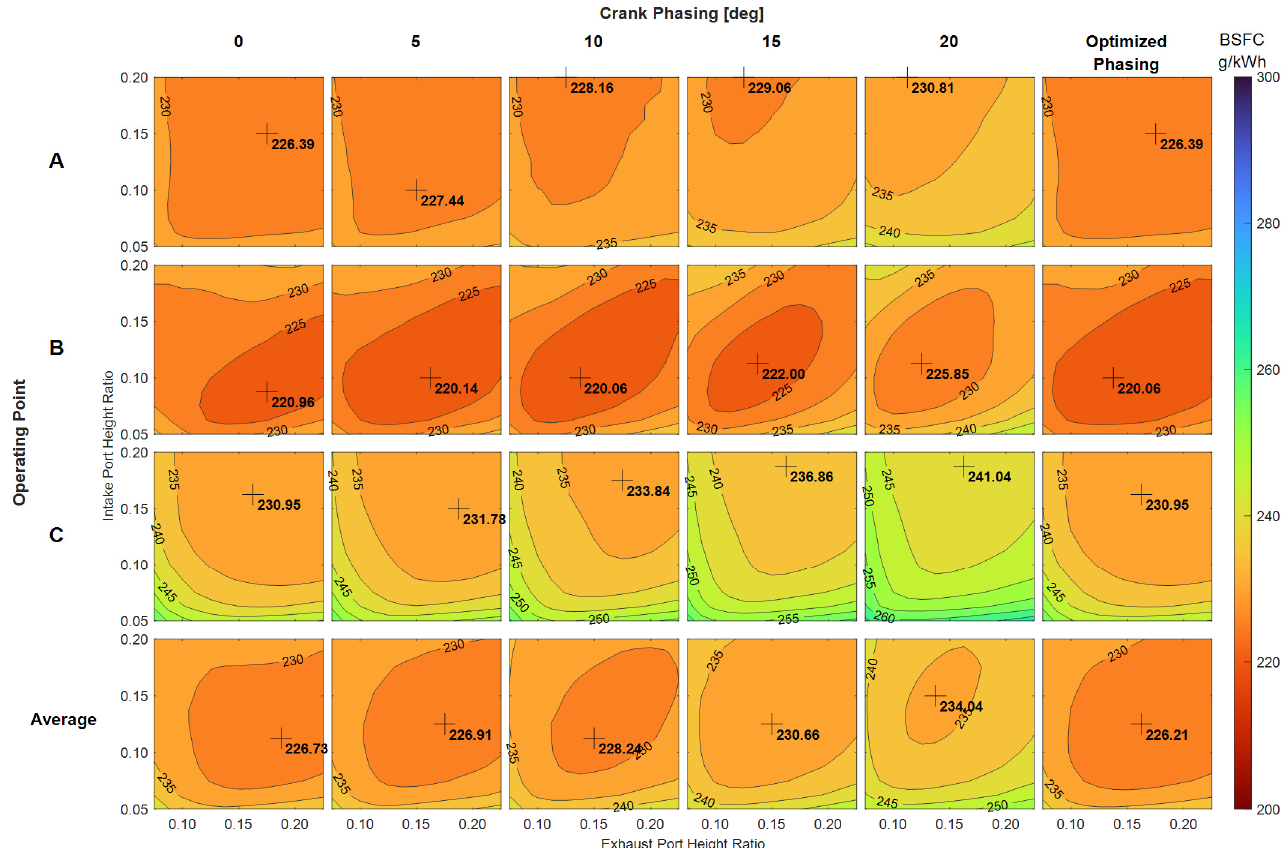
Figure 13. Variation in BSFC with crankshaft phasing and intake and exhaust port height-to-stroke ratios at points A, B, and C (1500 min − 1 , 3-bar BMEP; 1500 min − 1 , 12-bar BMEP; and 3000 min − 1 , 10-bar BMEP, respectively), with each operating at its optimal λ setting. The right-most column shows the BSFC contour for best crankshaft phasing at each operating point. The bottom row shows the mean BSFC across the three operating points (i.e., assuming equal weightings).